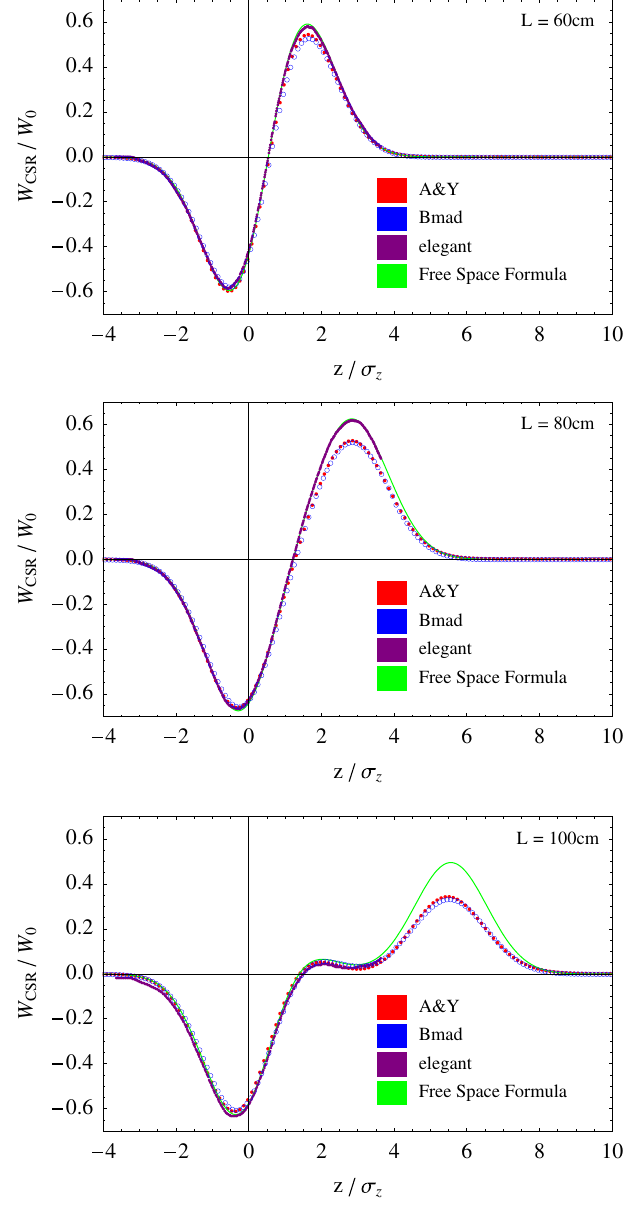
FIG. 10. (Color) Length dependence for the transient cases using the wide chamber in parameter set D with magnet lengths of 60 cm (top), 80 cm (middle), and 100 cm (bottom). The codes deviate from the CSR-wake formula of Eq. (47) for longer magnets, but Bmad (circles) agrees with